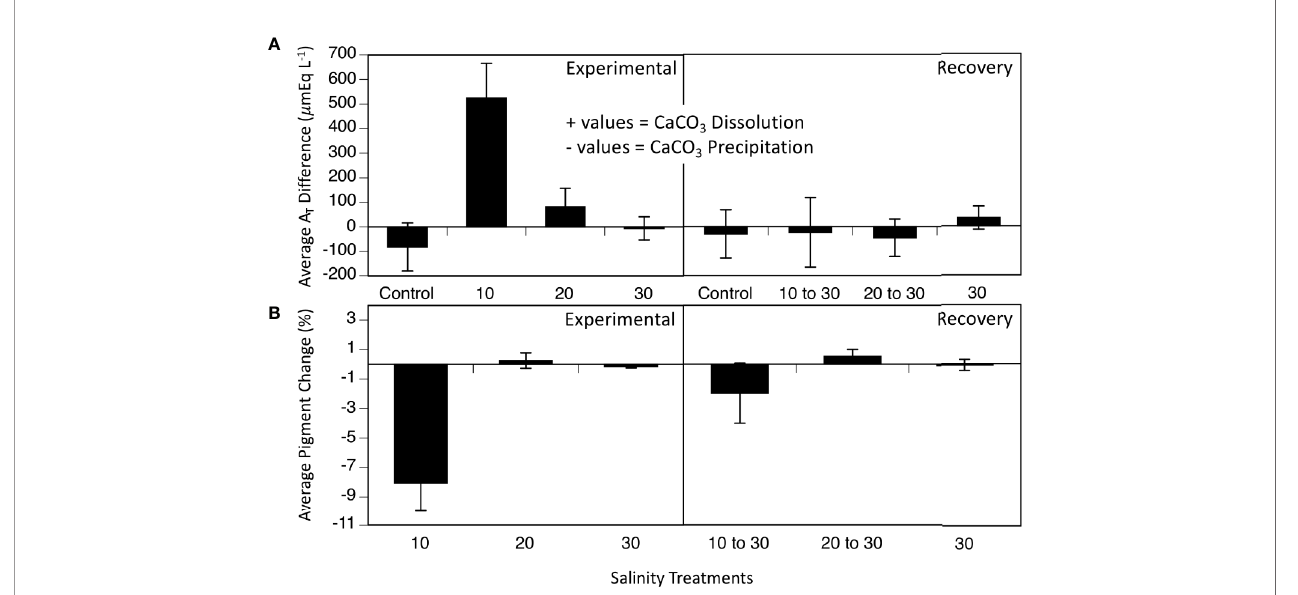
FIGURE 3 | (A) Average A T differences (n = 4) over 5 weeks at varying salinities (10, 20, 30, and control without any cobbles) and 5 weeks of recovery, when all treatments were at 30. (B) Average pigment loss over 5 weeks of salinity treatments (10, 20, and 30) and 5 weeks of recovery, when all treatments were at 30. Values are means ± SE.